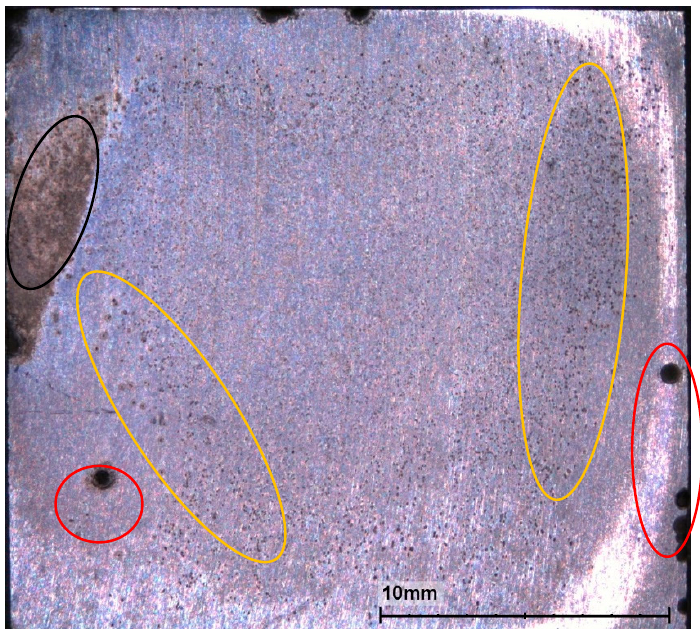
Figure 14. An image for the sample S9 exposed to SW + bacteria for 7 days (after cleaning the surface). Many small pits (yellow, diameter < 0.1 mm, >80% area) and a few big pits (red, diameter > 0.5 mm, ~3% area) were in the steel. Uniform corrosion took place in a small area (black, ~5% area).